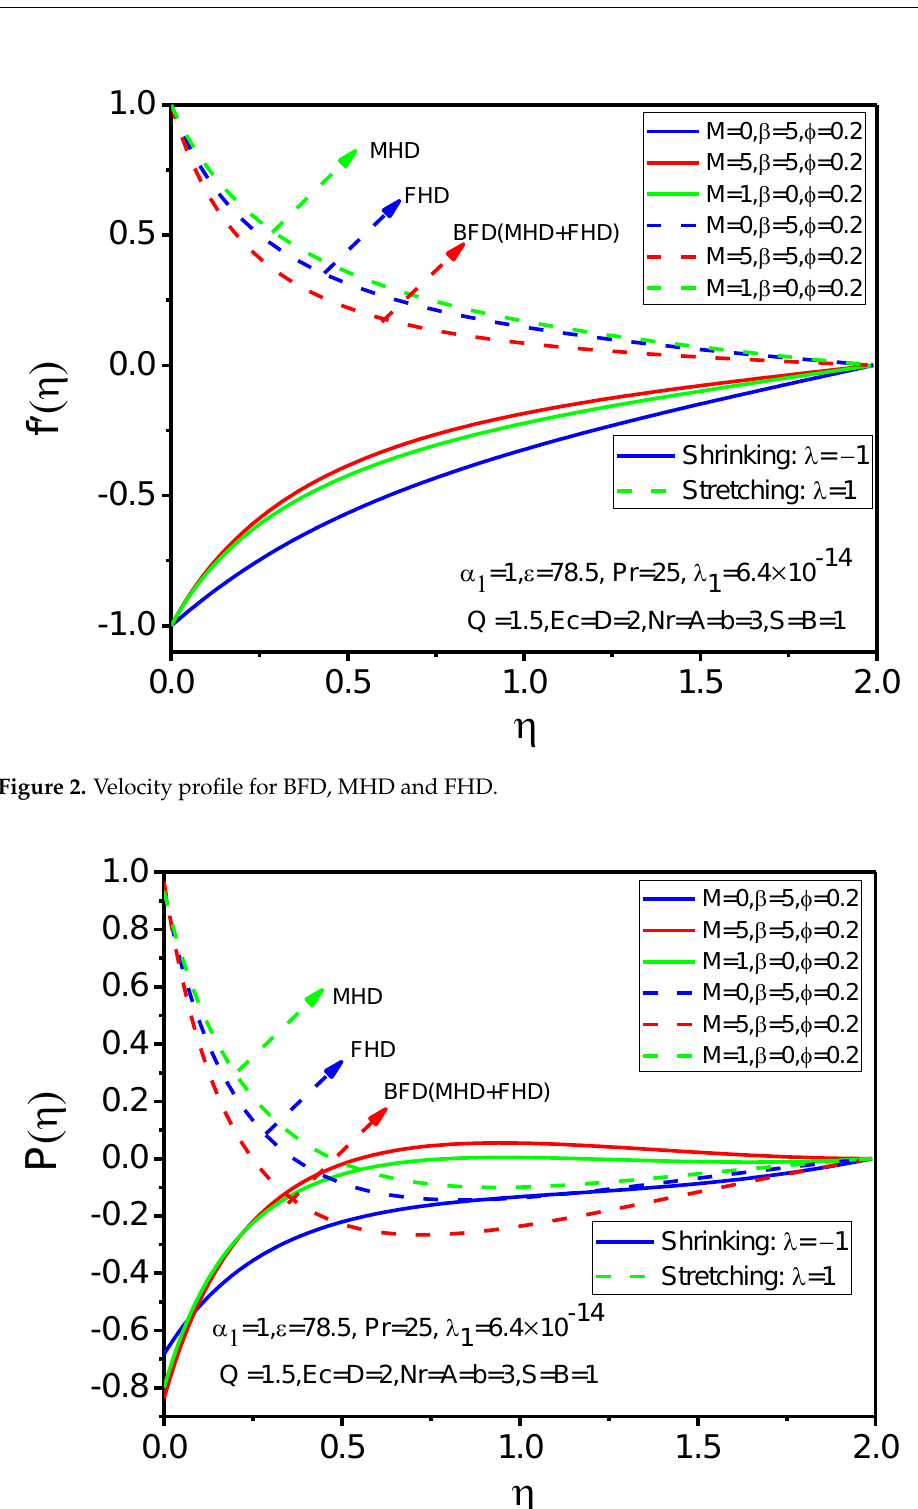
Figure 3. Pressure profile for BFD, MHD and FHD.